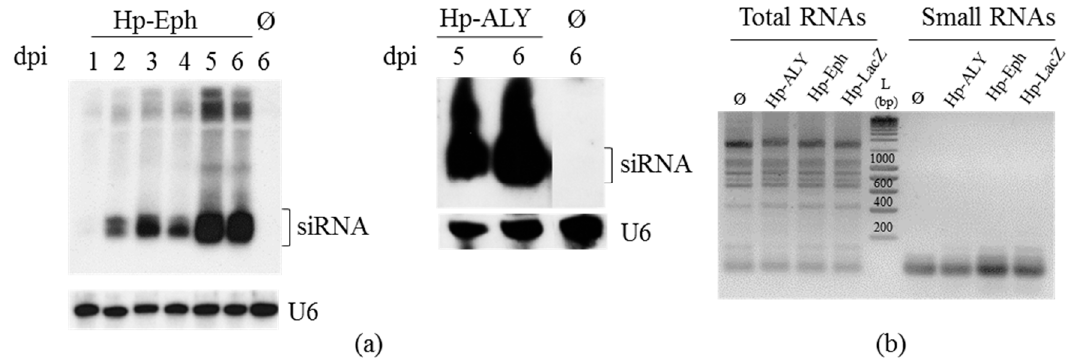
Figure 3. ( a ) siRNA detection and purification from N. benthamiana transiently expressing Hp-Eph and Hp-ALY. siRNA were extracted at different days after infiltration (dpi) of N. benthamiana leaves with Agrobacterium carrying pFGC5941-derived plasmids expressing hairpin RNAs targeting Eph or ALY . Each lane was loaded with 10 µ g of PEG-purified small RNAs and the blots were hybridized with DIG-labeled probes. The blot on the left was further stripped and hybridized with a DIG-labeled U6 probe as loading control, whereas the U6-probe was added together with the ALY-probe in the blot on the right. The two panels of this blot were manually organized (probe detection placed under siRNA) for consistency. Ø: Non-infiltrated N. benthamiana leaves; ( b ) 2.5% agarose gel loaded with 1.0 to 1.8 µ g of total RNAs extracted from N. benthamiana leaves five days after infiltration with Agrobacterium bearing pFGC5941-derived plasmids expressing hairpin RNAs targeting Eph , ALY and lacZ . Small RNAs were purified with PEG and used for aphid feeding; 0.8 to 1.0 µ g of small RNAs were loaded on the gel. The gel was stained with ethidium bromide. The size (in bp) of the DNA ladder (L) is indicated.